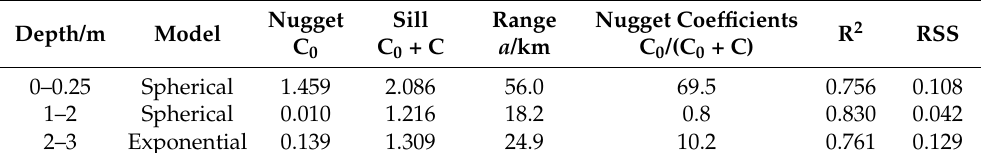
Table 3. Variogram model and parameters.